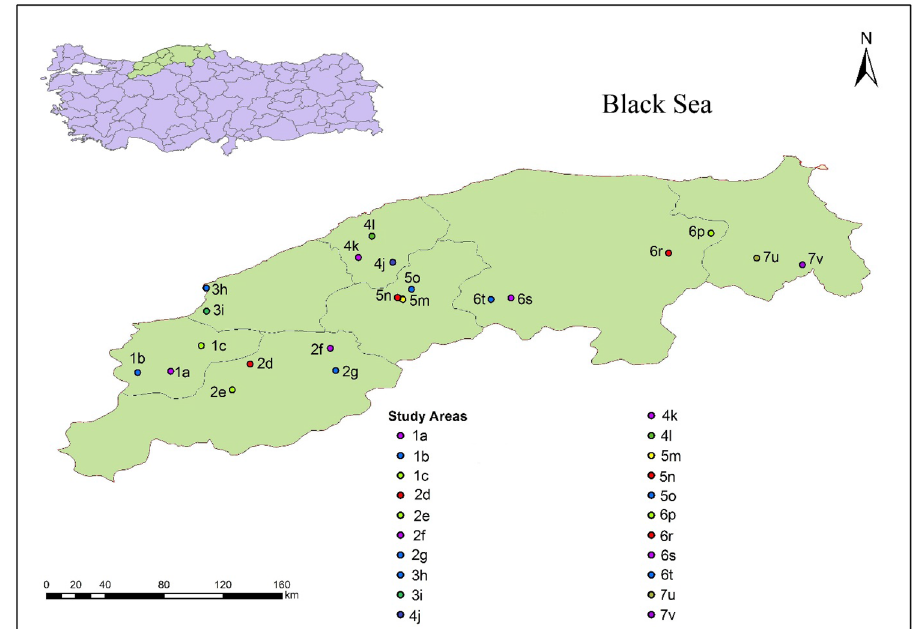
Figure 1. Map showing the log depots in the study areas (Provinces: 1-Duzce (DU), 2- Bolu (BO), 3-Zonguldak (ZO), 4-Bartın (BR), 5-Kastamonu (KS), 6-Karabuk (KR) and 7-Sinop (SI). Letters on the map are the codes of the log depots in the provinces of the study area. The map was plotted using by ArcGis 10.3 version which is used for mapping and editing